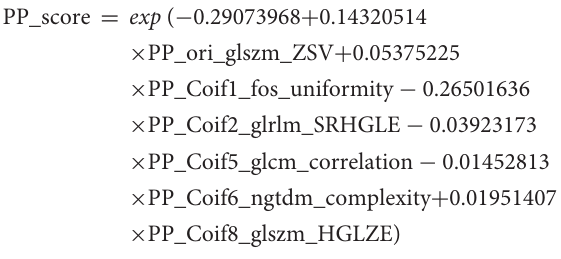
TABLE 3 | The univariate and multivariate analyses for clinical features in training group.